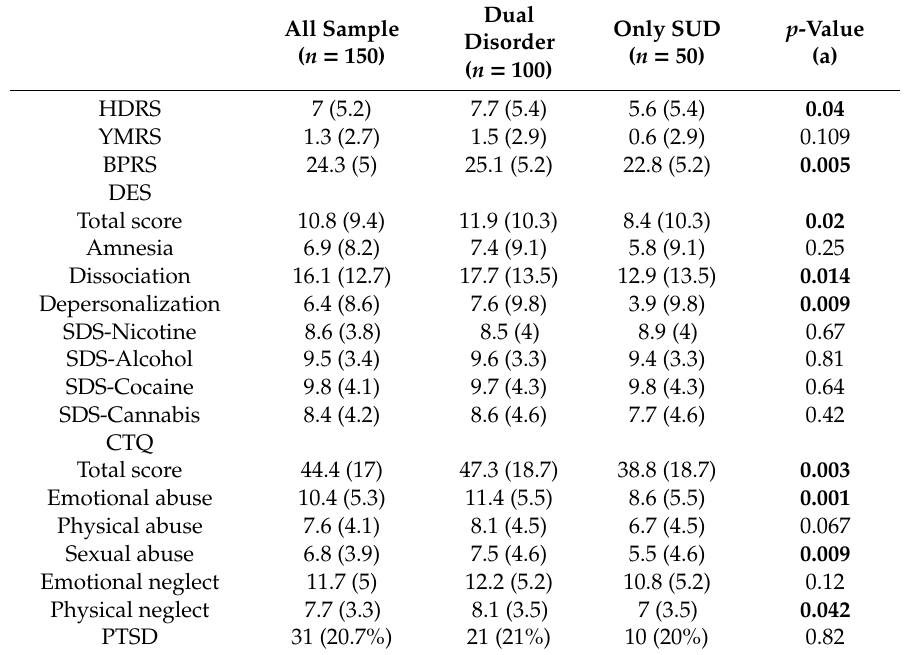
Table 3. Clinical di ff erences between patients with dual disorder diagnosis and only Substance Use Disorder (SUD) diagnosis. Data are presented as mean (SD).